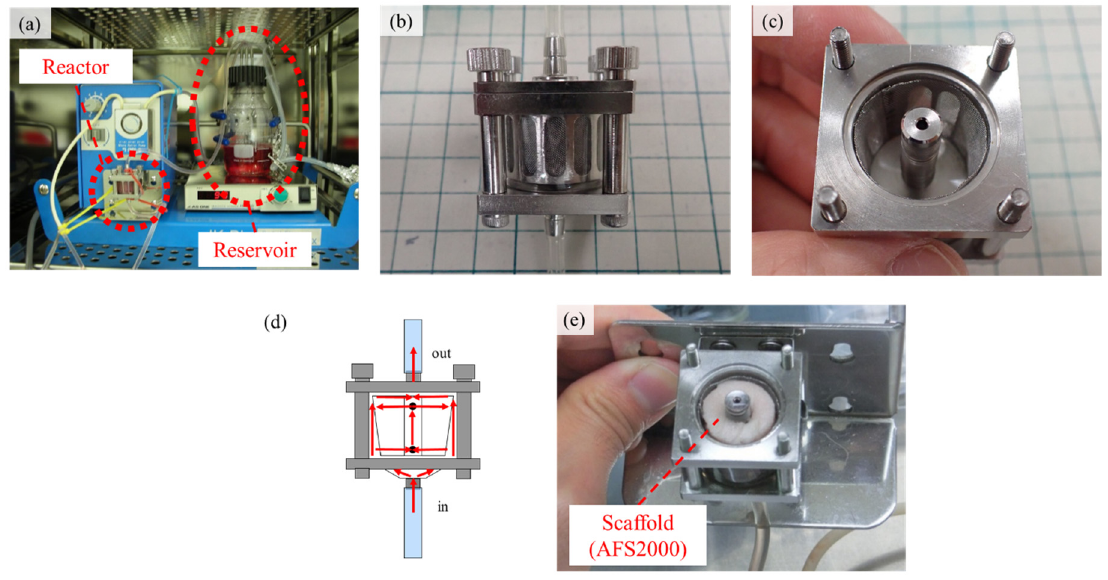
Figure 7. Photographs of a RFB. ( a ) Overview of a RFB, ( b , c ) structure of the bioreactor, ( d ) schematic of medium flow in the bioreactor, and ( e ) AFS2000 placed in the RFB.